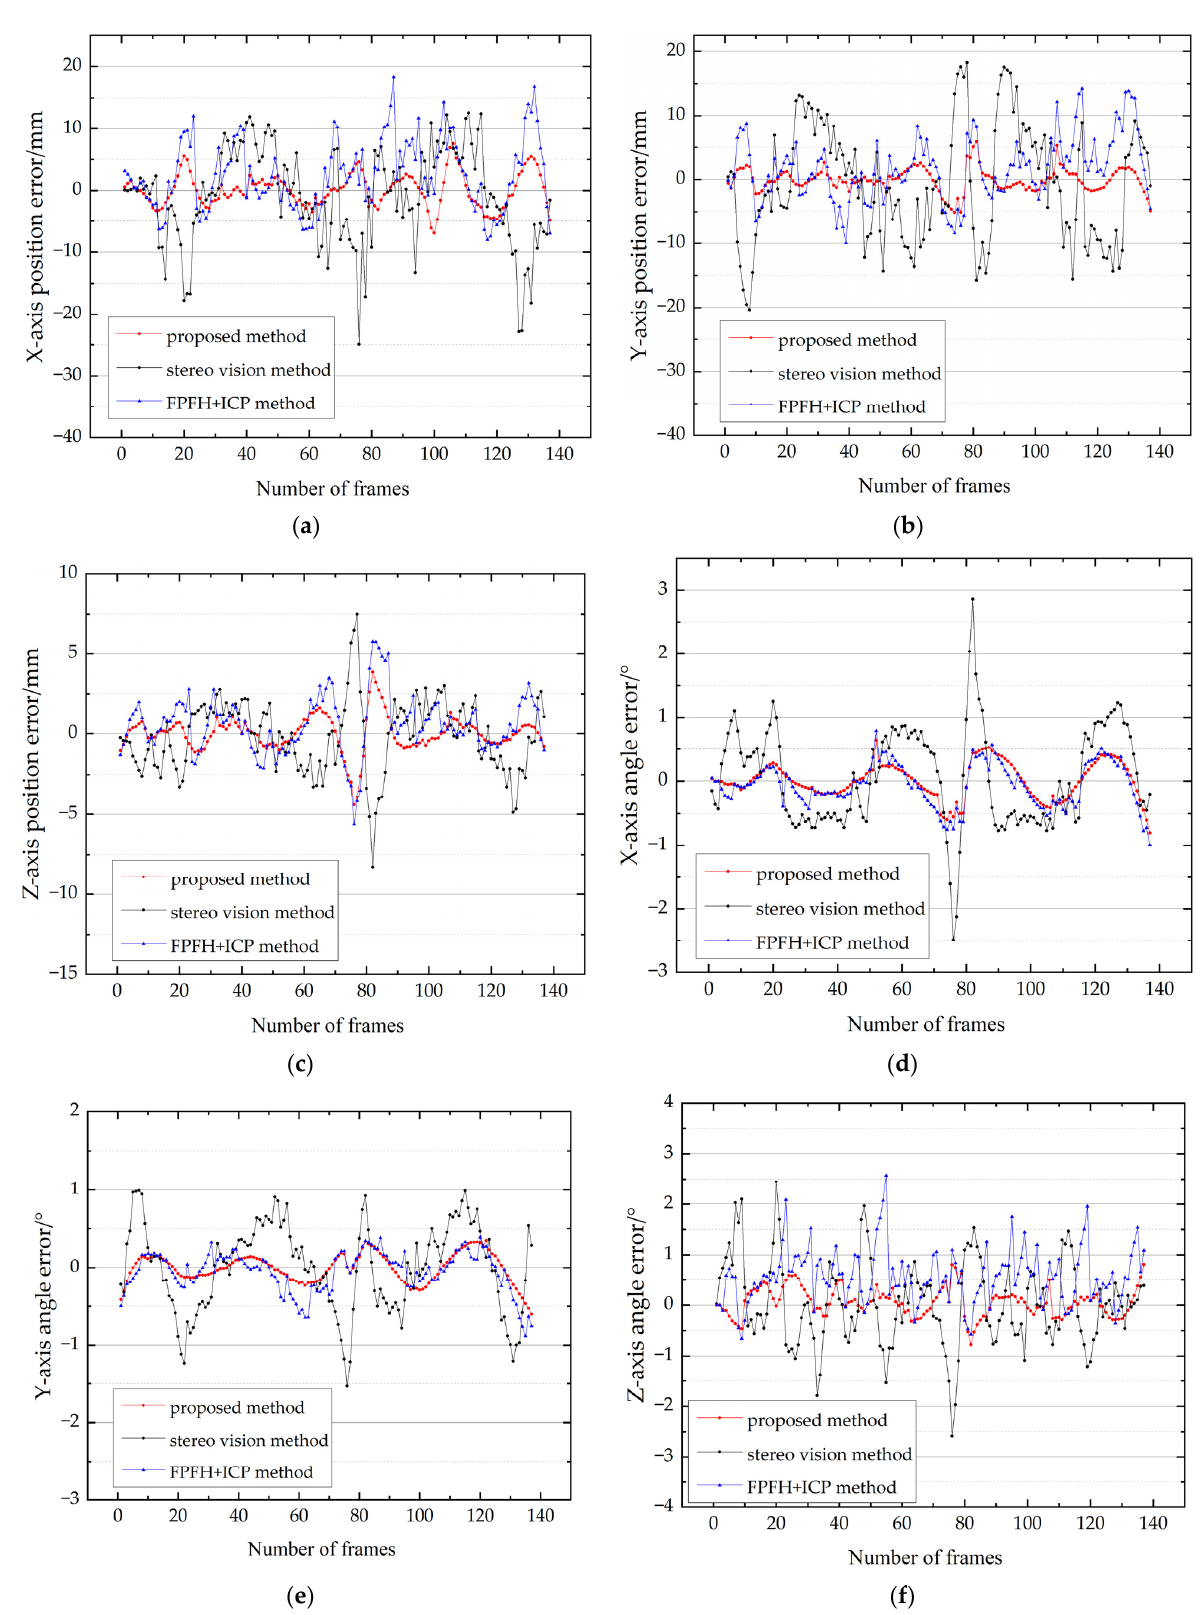
Figure 16. Comparison of the error results of the different methods at low speed: ( a ) X-axis position error; ( b ) Y-axis position error; ( c ) Z-axis position error; ( d ) X-axis angle error; ( e ) Y-axis angle error; ( f ) Z-axis angle error.